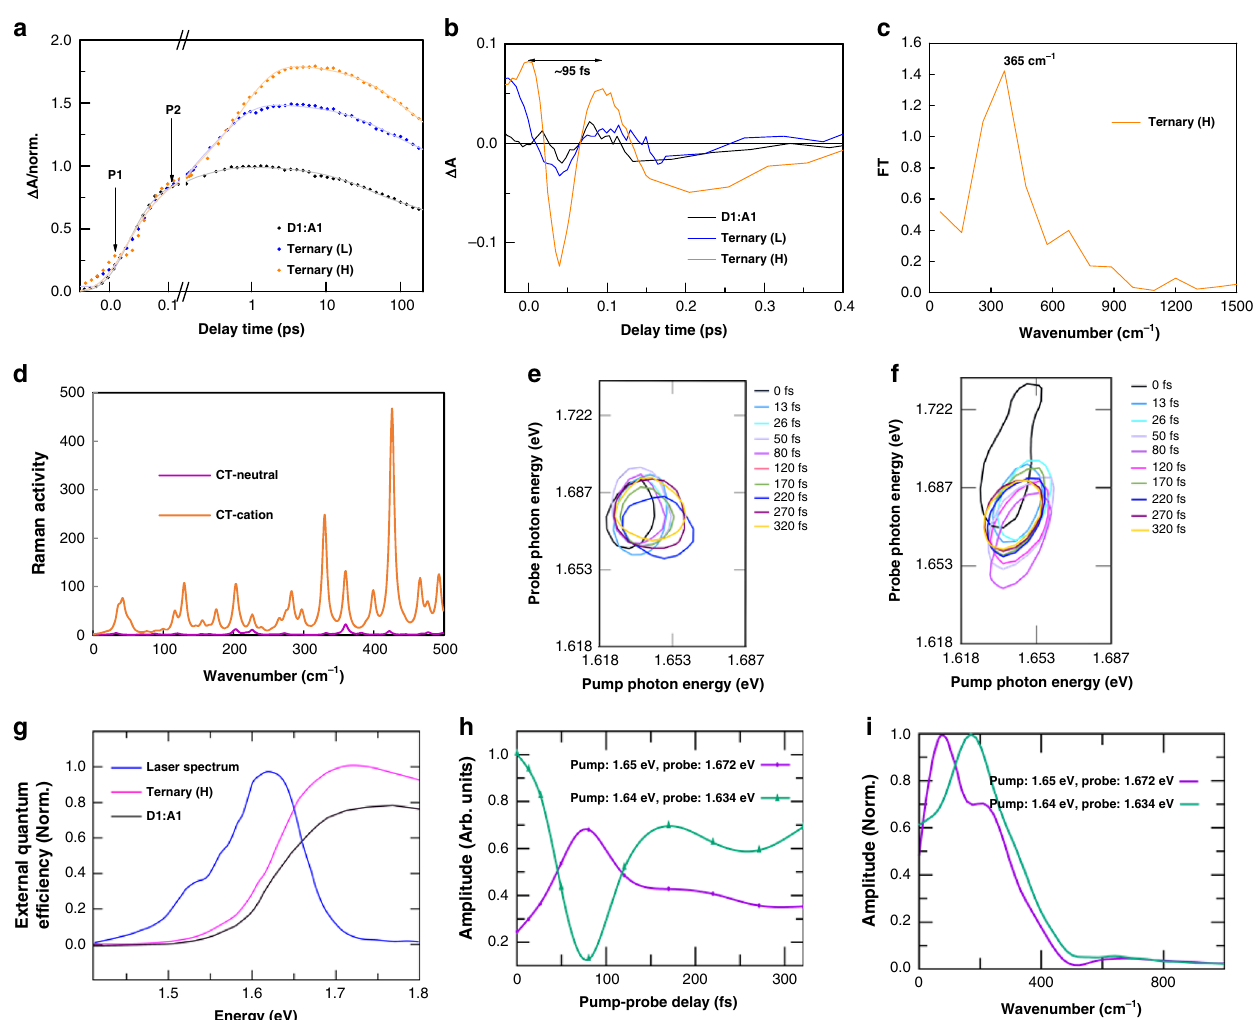
Fig. 3 Coherent dynamics of blends. a Kinetic process of the three blends, pumped at 700 nm and probed at 860 nm, normalized at around 100 fs. The charge separation process occurred before 100 fs, followed by the charge generation process. The oscillation signal of Ternary (H) as indicated by the arrow. b Corresponding oscillation signal. c Fourier transformed spectrum reveals the frequency of the oscillatory components at 365 cm − 1 . d Raman spectra calculated at the B3LYP/6-31 + G(d) level of theory for the neutral and charged CT conformer. e A zoomed version of the 2DPS peak shifts (contour at 90% of the maximum) for the D 1: A 1 and f Ternary (H) devices. The color indicates the time delay between the pump and the probe. g EQE of the two devices as a function of excitation energy, and the excitation spectrum of the laser. h Quantum beats observed at two selected positions in the 2DPS spectra of the Ternary (H) device and i the corresponding